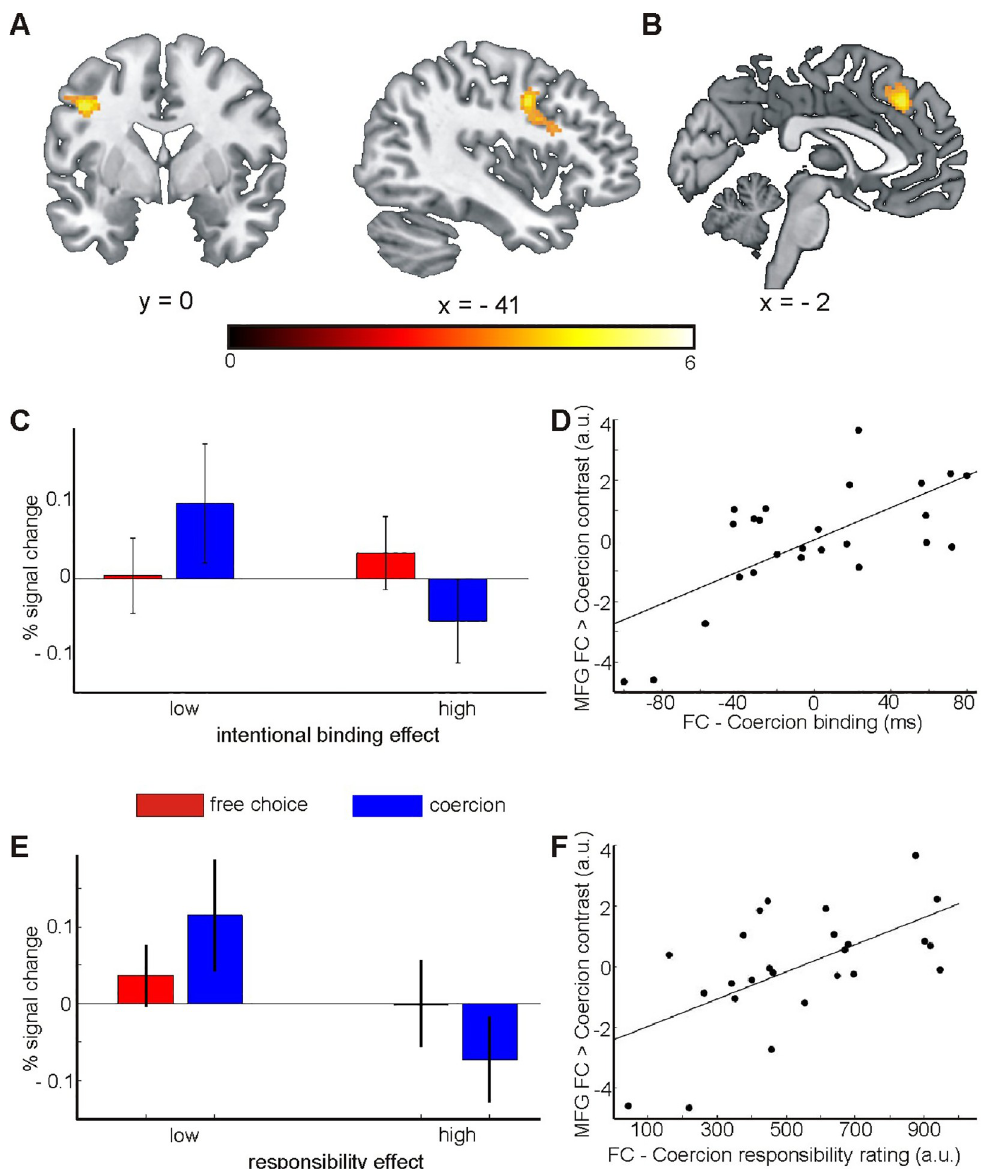
Fig 2. Main effect of coercion and interaction with coercion effect on binding. A shows the main contrast Coercion > FreeChoice. B shows the MFG cluster of the regression of the binding coercion effect against the FreeChoice > Coercion contrast. C shows percent signal change for the region shown in B , for participants sorted by median split according to their coercion effect on binding. D shows the correlation between the Free choice > Coercion contrast in the MFG and the Free Choice > Coercion difference in binding. E shows the percent signal change for the same region, with participants sorted by median split according to their coercion effect on explicit responsibility ratings. F shows the correlation between coercion effects on MFG activity and responsibility ratings. Error bars represent standard errors of the